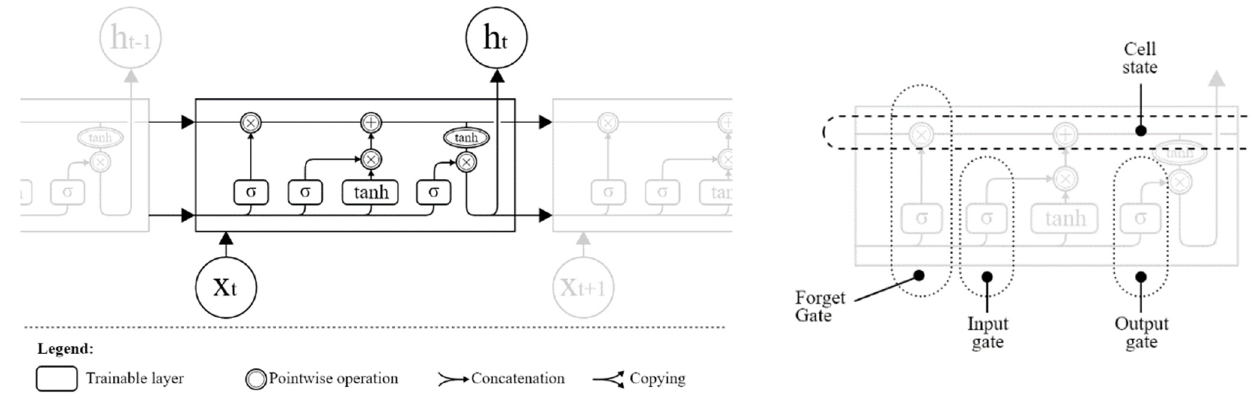
Figure 6. LSTM architecture and cell.